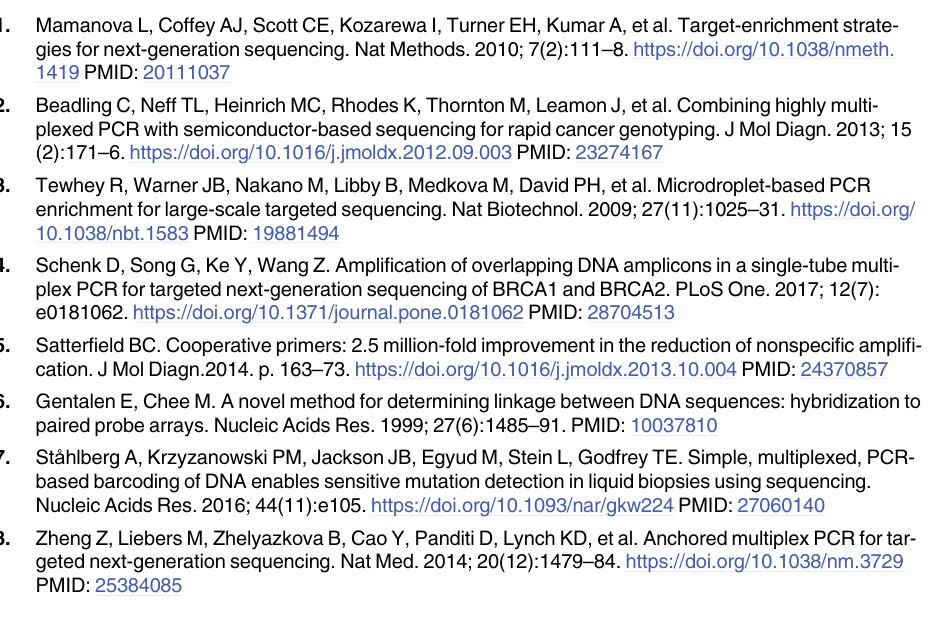
S2 Table. Assay validation sequencing statistics. S3 Table. Variant